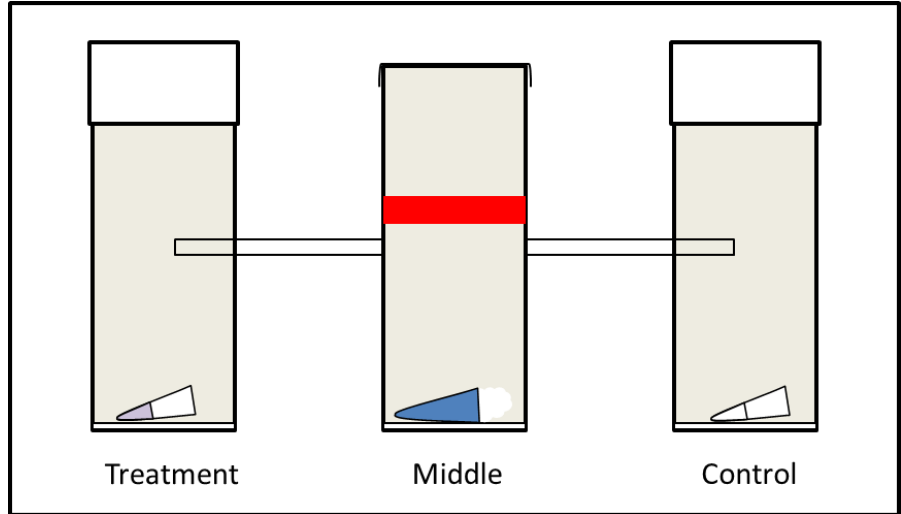
Figure 1. Experimental set-up of the two-choice trap-based bioassays that was used to test the attractiveness of identified R. fruticosus volatiles . The set-up consisted of three containers with a moist cotton pad placed on the bottom to provide sufficient humidity. At the start of each experiment, around 30 flies were released in the middle container, which contained ad libitum water and which was connected to the outer containers via tubes with a length of 6.5 cm. The outer container either contained an Eppendorf tube with a volatile compound identified from R. fruticosus (in an amount corresponding to that estimated to be present in 10 berries and dissolved in 100 µ L of mineral oil) (treatment arm) or mineral oil solvent only (control arm). After 24 h, the overall attractiveness was assessed based on the number of flies present in each container.